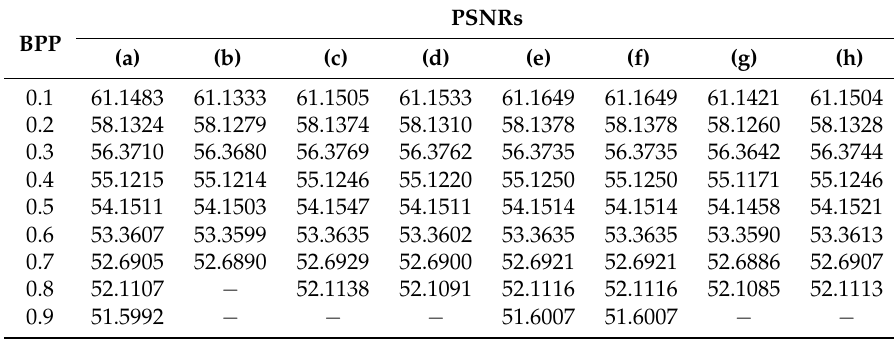
Table 3. PSNR measurement for the eight depth maps when σ = 1.